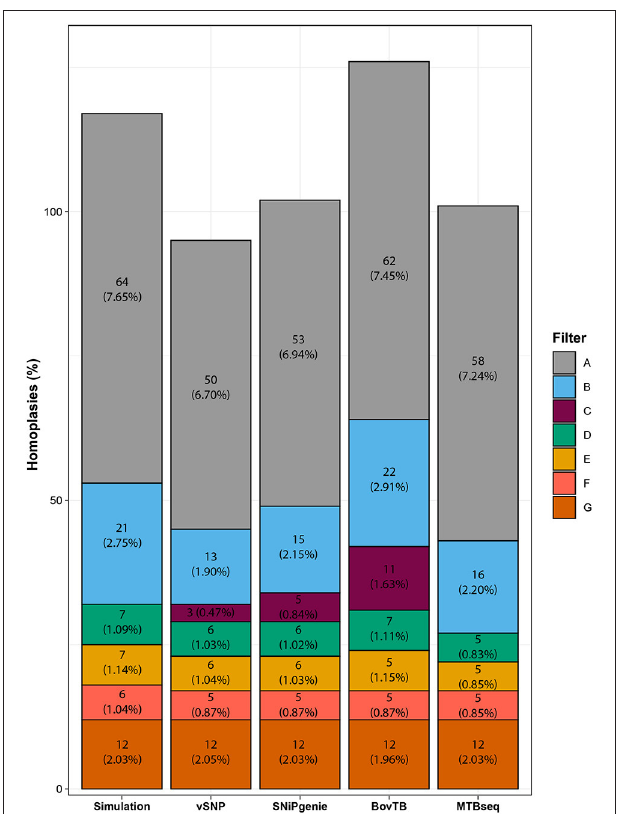
FIGURE 2 | Effect of hard filtering in the performance of the evaluated pipelines when compared to the simulated dataset as indicated in the (A) recall and (B) precision rates. Asterisks indicate filters in MTBseq for which the minimum coverage threshold was adjusted.